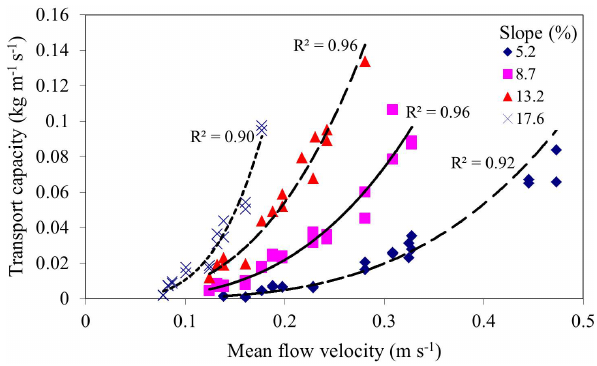
Fig. 4. Relationship between measured sediment transport capacity and mean flow velocity for different slope classes. All sediment types were